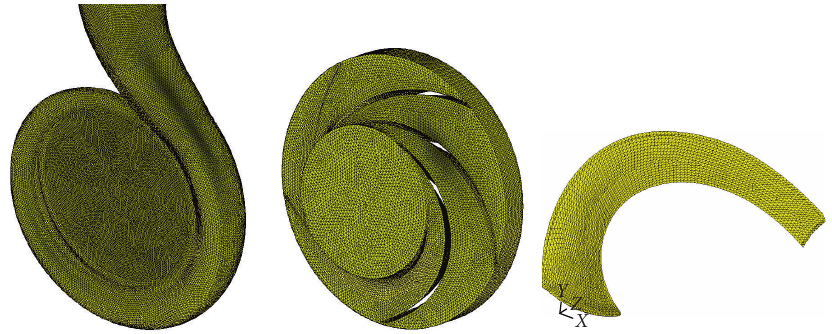
Figure 6: Meshes of the volute and impeller flow domains and triangular mesh on an isolated blade surface.